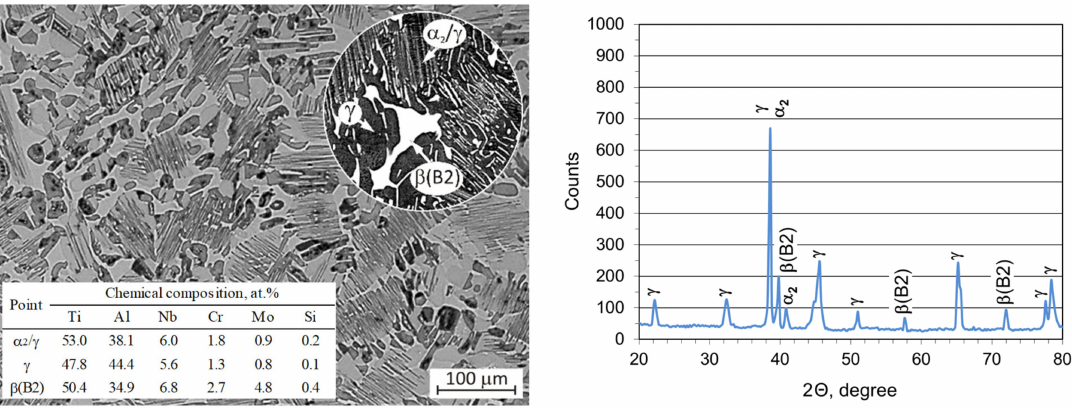
Figure 4. Microstructure and X-ray diffraction patterns of Ti-45Al-5Nb-2Cr-1Mo-0.5(B,C)-0.2Si alloy. The examinations of the microstructure using the transmission electron